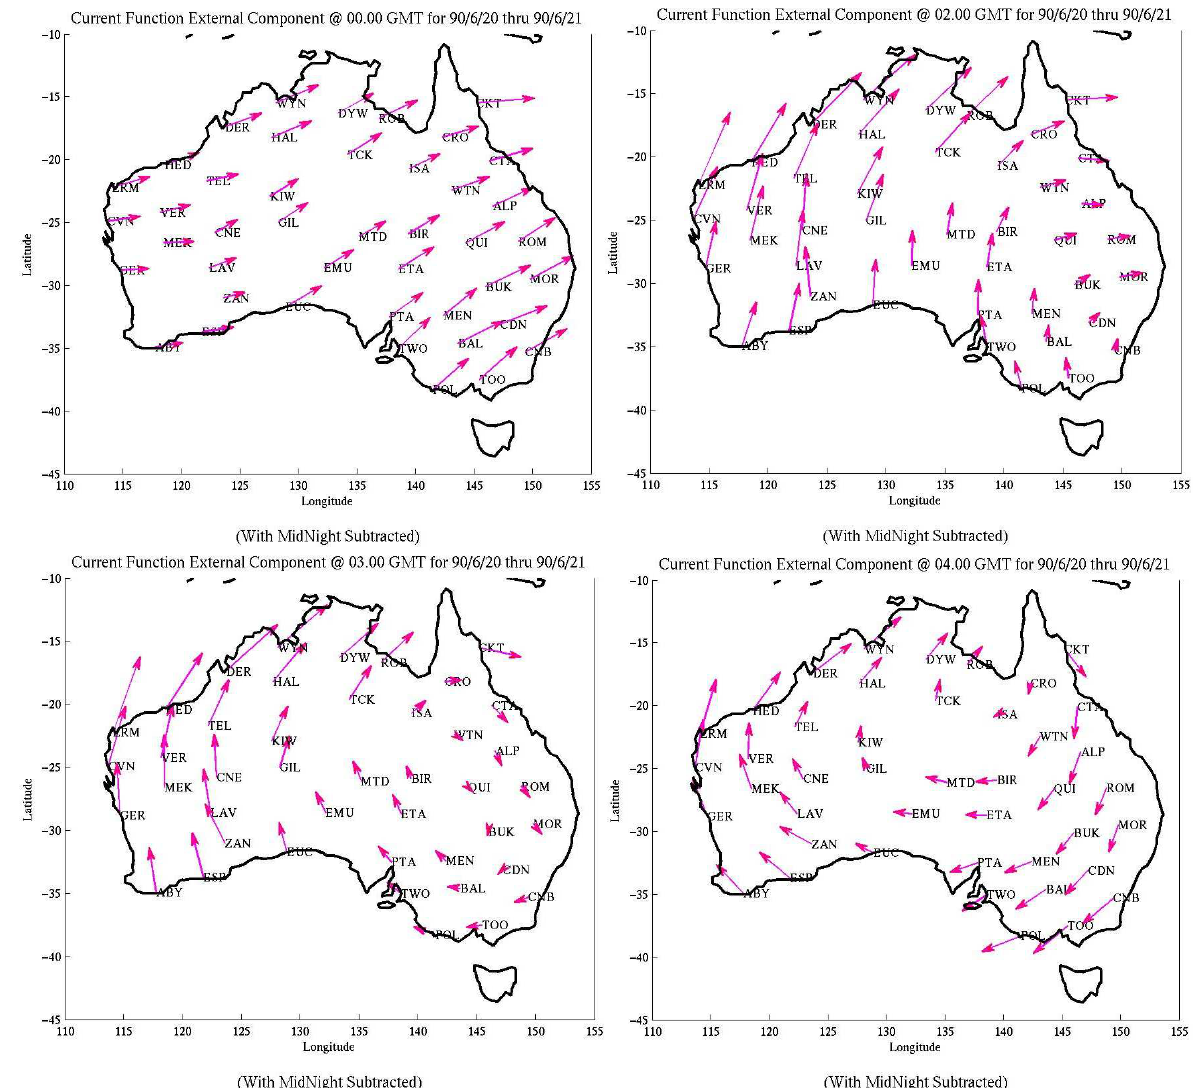
Fig. 1. Equivalent current systems over Australia on 21 June 1990 at 00:00, 02:00, 03:00 and 04:00 UT (09:00 to 13:00 LT at 135 ◦ longitude). An arrow length equivalent to 5 ◦ of longitude westward corresponds to a magnetic field (rotated 90 ◦ clockwise) of 27, 25, 21 and 24nT, respectively, 00:00, 02:00, 03:00 and 04:00